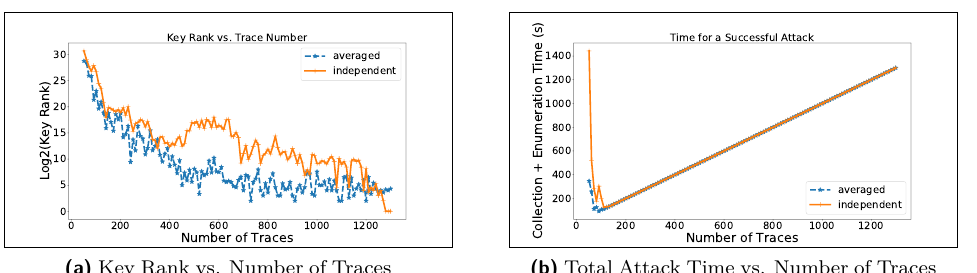
Figure 14: Comparison between independent profiles and averaged profiles, for 5000 · 500 template traces and 2000 · 500 attack traces at a distance of 10 cm in a home